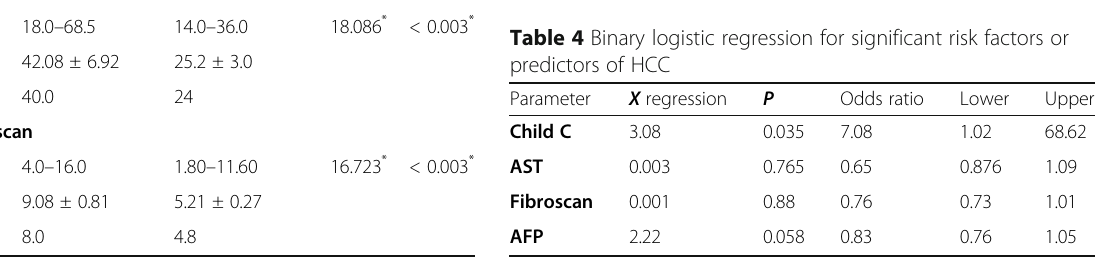
Table 3 Comparison between the two studied groups according to median and IQR of Fibroscan Median of Fibroscan